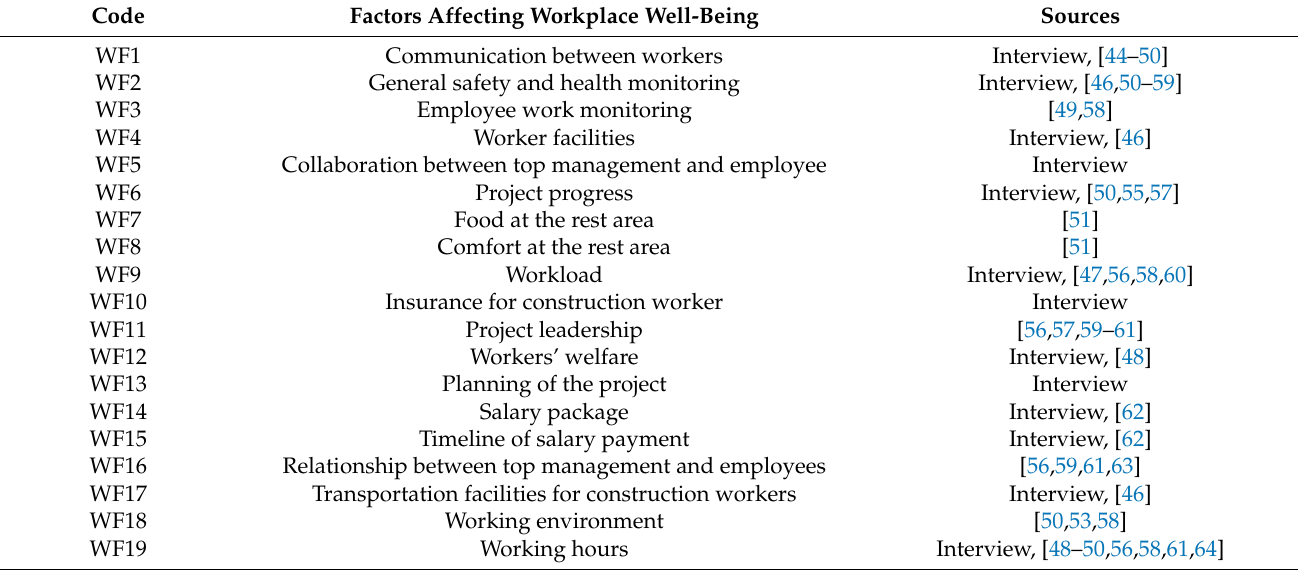
Table 1. Factors affecting workplace well-being from the interviews and literature